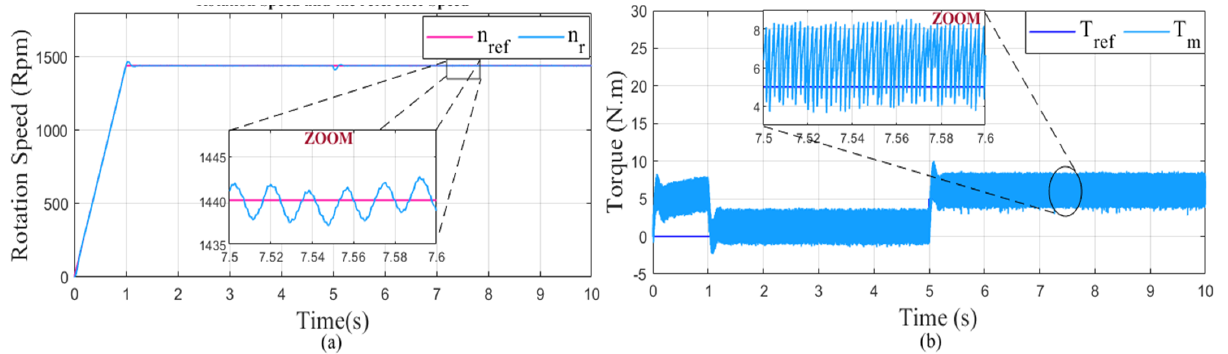
Figure 29. Performance with Ball bearing defect of IM with DTC control: ( a ) rotation speed and ( b ) motor torque.